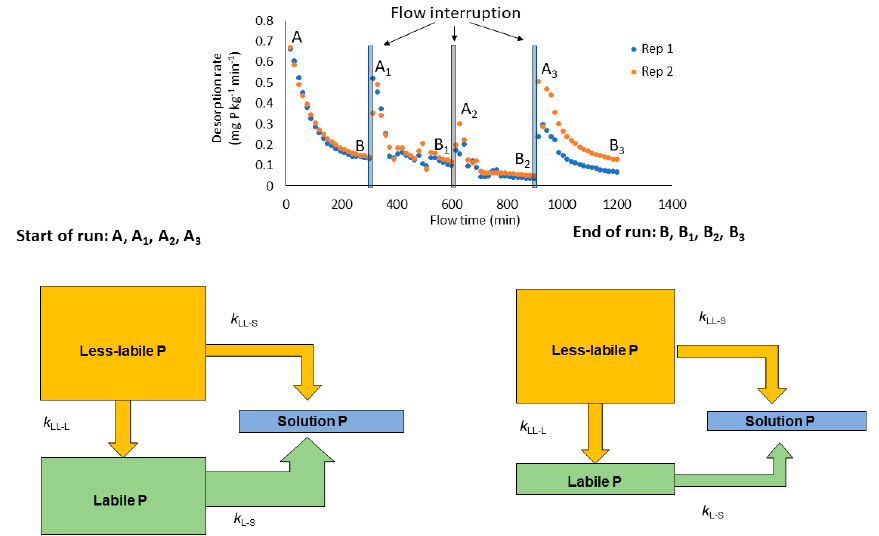
Figure 9. Changes in phosphorus (P) desorption rate over three interruption tests where flow was ceased through the cell for 48 h, followed by re-start. Accompanying diagrams illustrate the change in less-labile (P in biomass, inner-sphere, and poorly-soluble minerals) and labile P (outer-sphere and highly-soluble minerals) with regard to their ability to replenish the solution P pool at the beginning (A, A 1 , A 2 , A 3 ) and end (B, B 1 , B 2 , B 3 ) of flow interruption. Arrow size indicates relative ability or rate of replenishment of labile pool by low-labile pool ( k LL-L ), low-labile pool to solution ( k LL-S ), and labile pool to solution ( k L-S